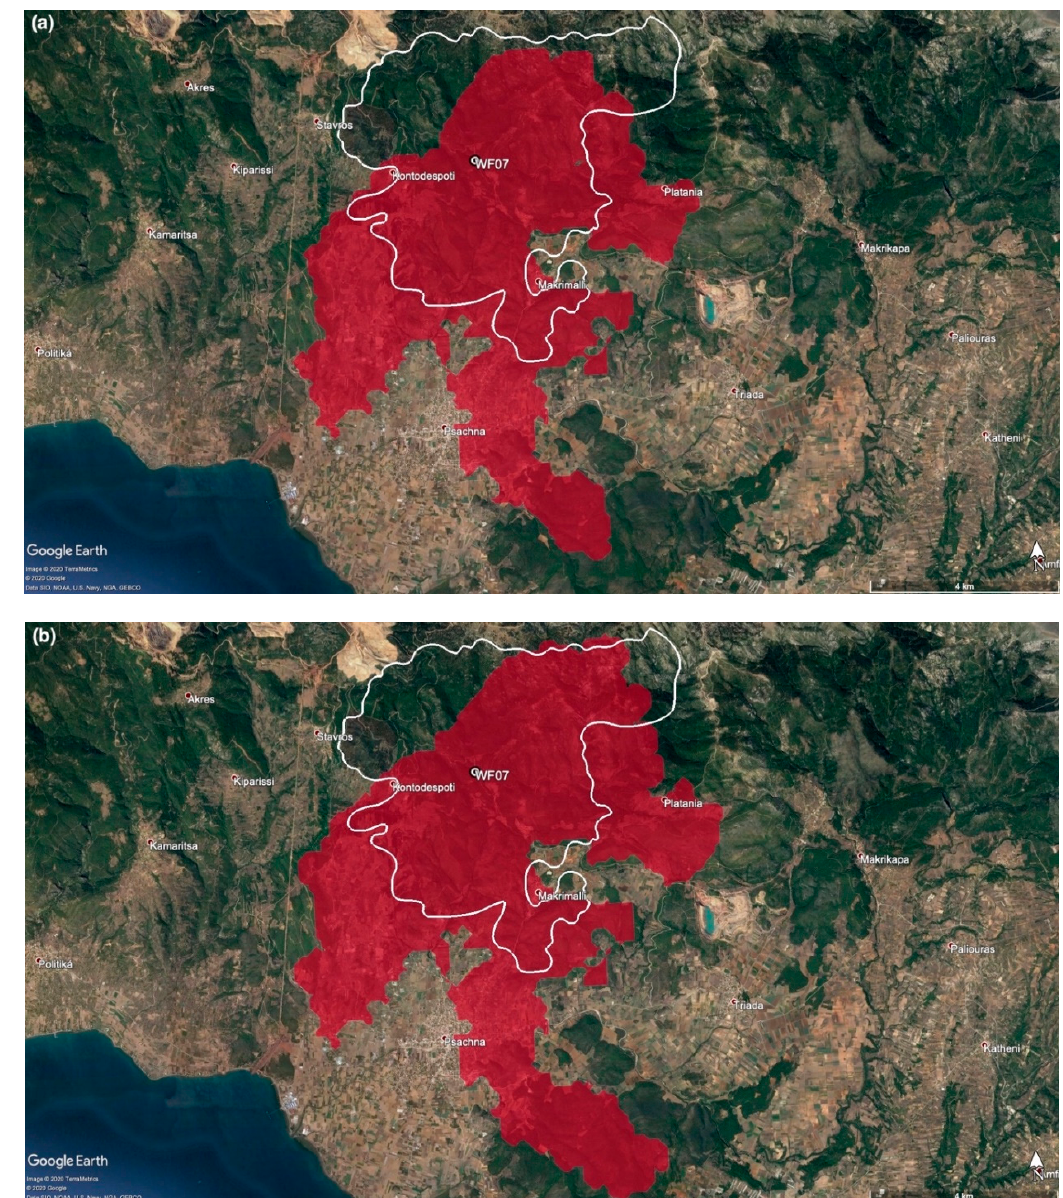
Figure 6. Visual comparison between actual (white contour) and predicted (red shades) wildfire perimeters for the Kontdespoti wildfire (WF07). ( a ) Operational wildfire spread prediction based on IRIS’s activation time, and ( b ) Retrospective wildfire spread prediction based on actual ignition time.